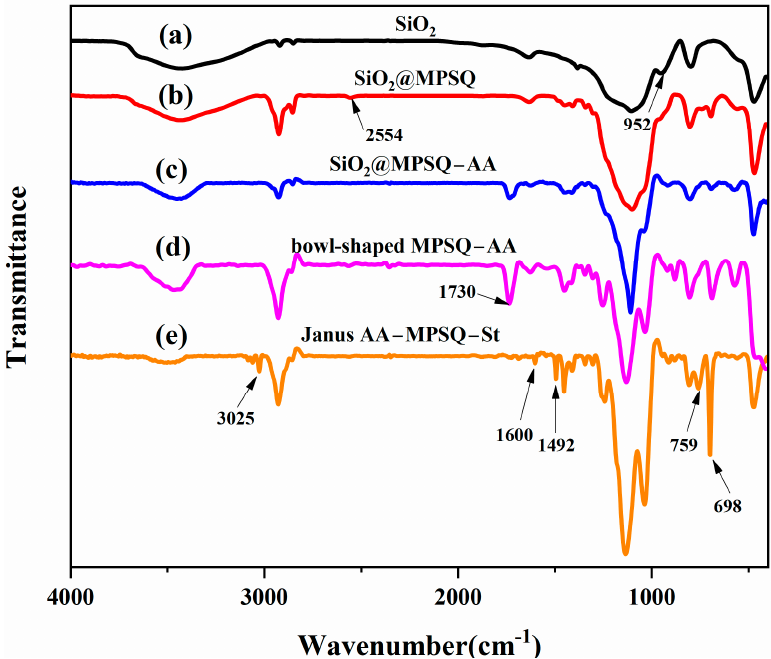
Figure 1. Fourier transform infrared (FT-IR) spectra of ( a ) SiO 2 , ( b ) SiO 2 @MPSQ, ( c ) SiO 2 @MPSQ-AA, ( d ) bowl-shaped MPSQ-AA, and ( e ) AA-MPSQ-St Janus particles.